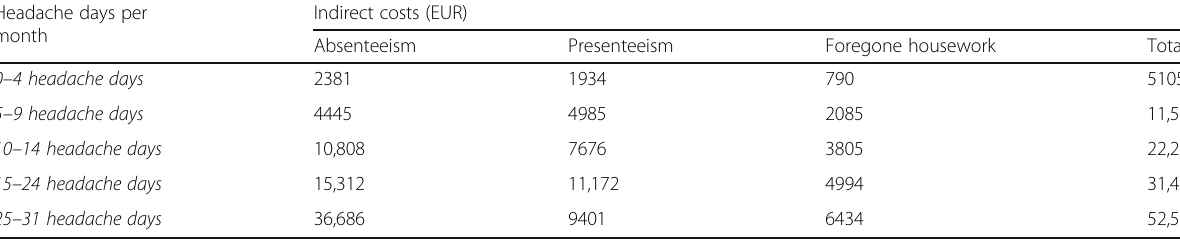
Table 4 Annual average indirect costs by number of headache days per month Headache days per month